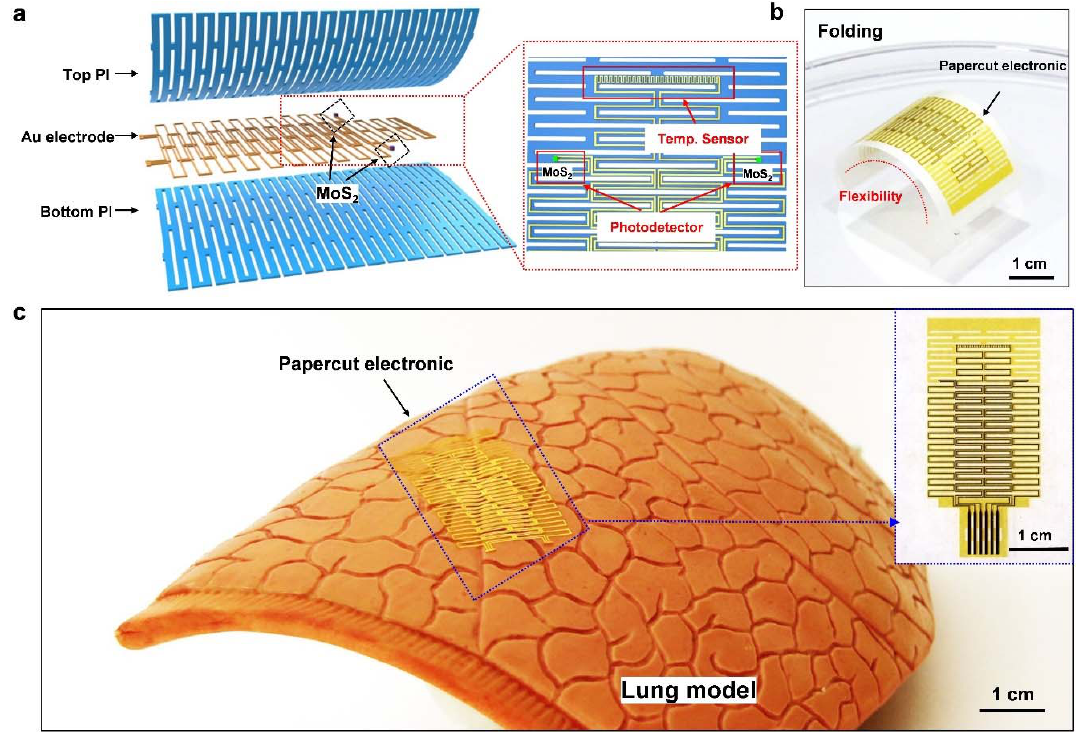
Figure 2. Structure of the paper ‐ cut electronic device: ( a ) The structure architecture and distribution of the paper ‐ cut electronic device, which consists of a sandwich structure comprising a temperature sensor and two symmetrical photoelectric sensors. ( b ) The device is attached to a piece of tape, and the photograph showing its bending characteristics. ( c ) Attachment of the device to the surface of the artificial lung.